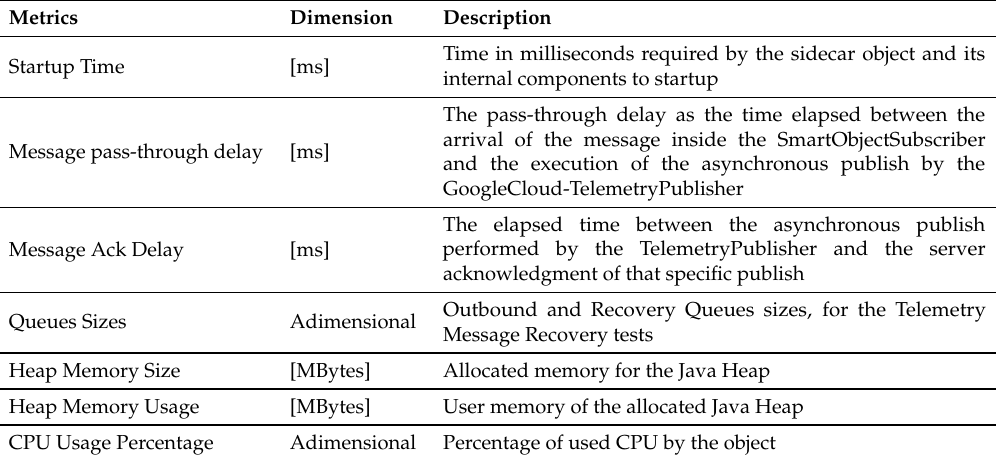
Table 1. Experimental evaluation’s